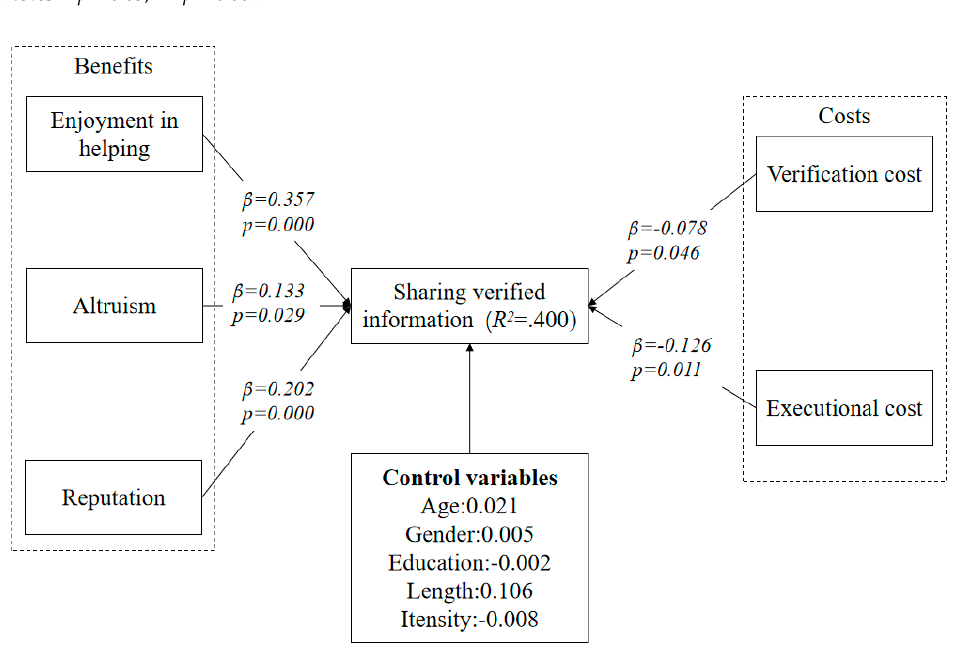
Figure 2. Analysis results of the hypothesized model.